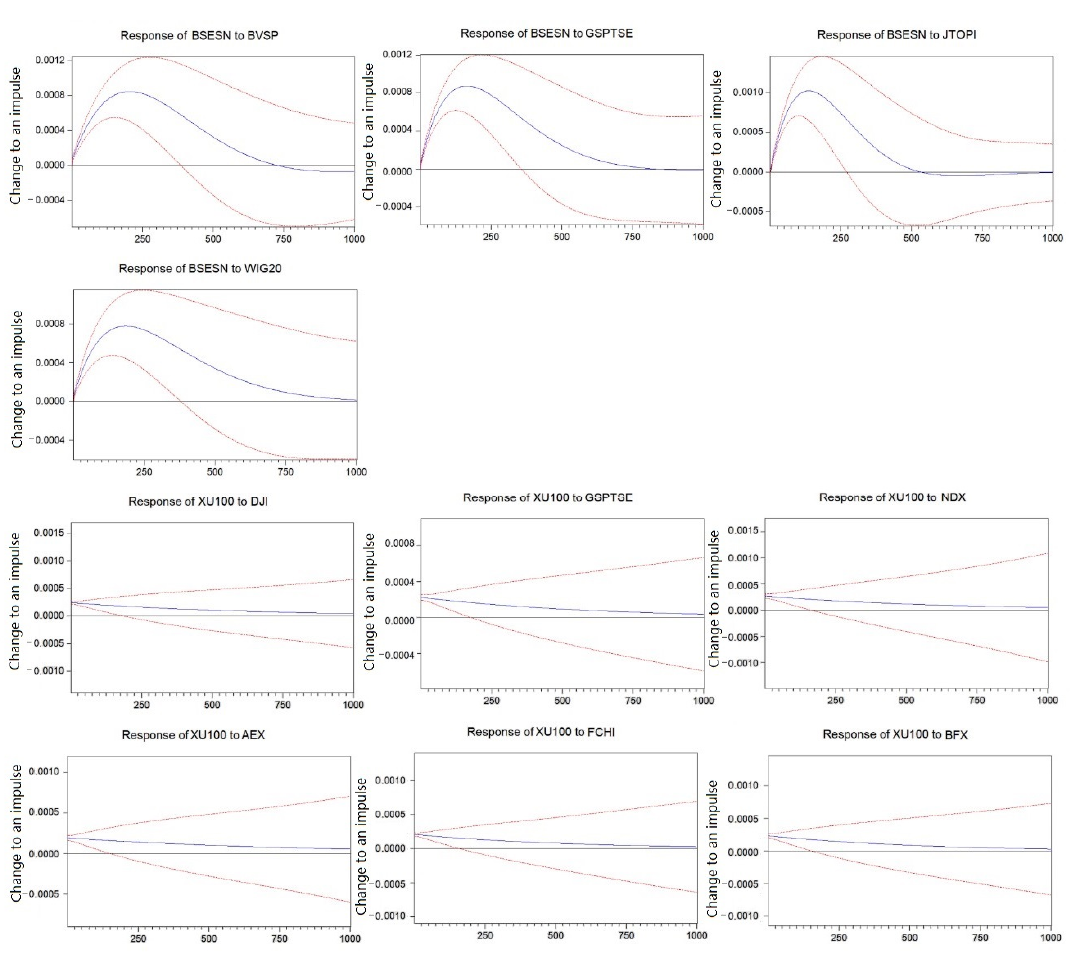
Figure 11. Impulse Response of var BSESN and var XU 100 to selected stock indices. Note: Blue lines represent the predicted results; red lines represent one positive/negative standard deviation from the predicted results.